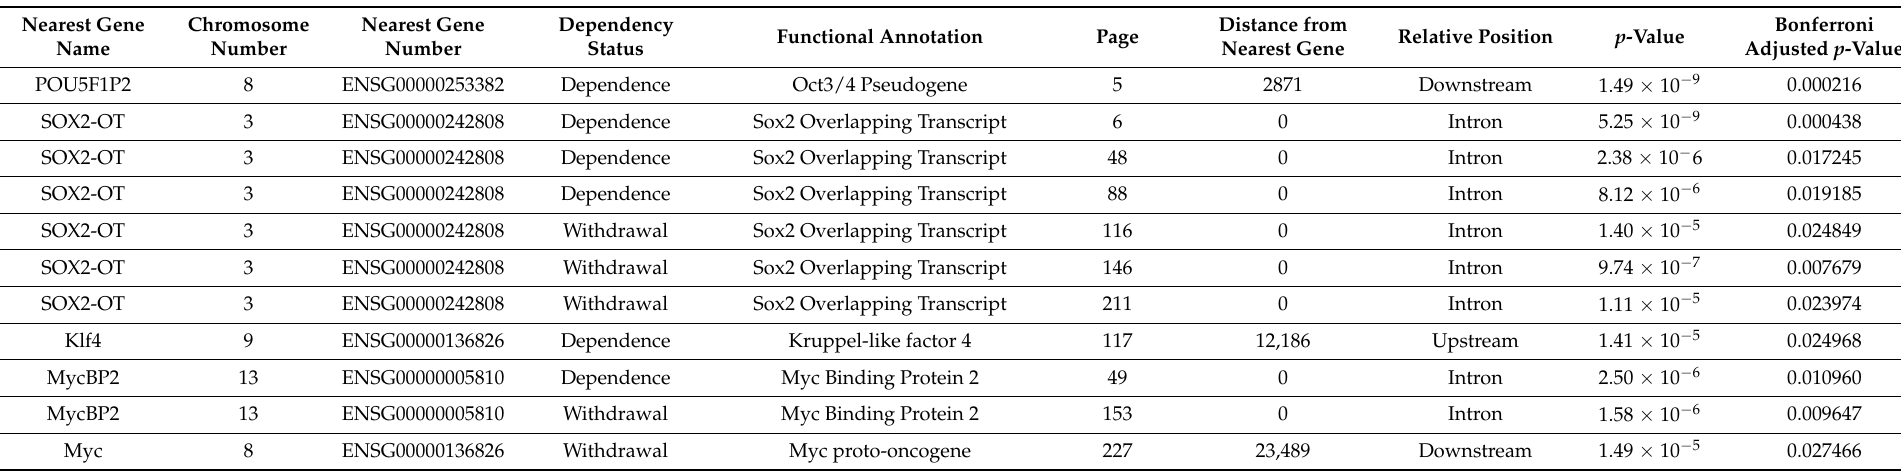
Table 3. Cannabis Impacts on Yamanaka Stem-Cell Factors, Schrott EWAS